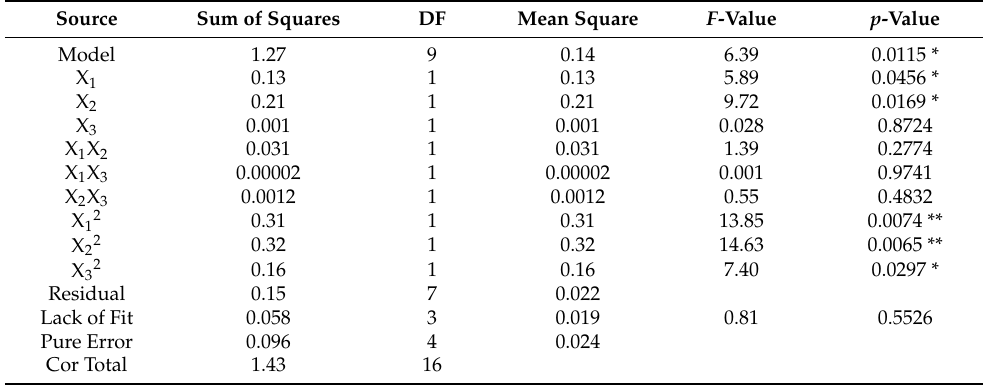
Table 4. Analysis of variance of response surface